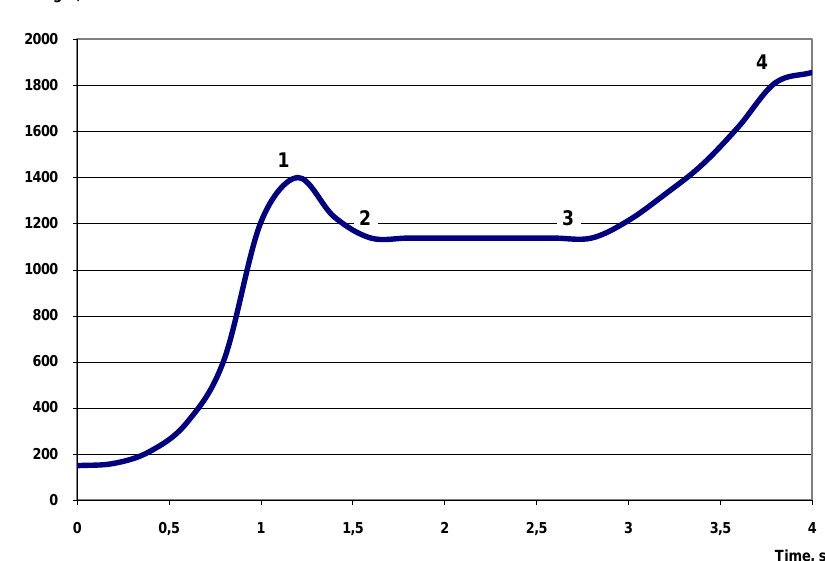
Diagram 2. Results of snatch with weight 65% from maximal